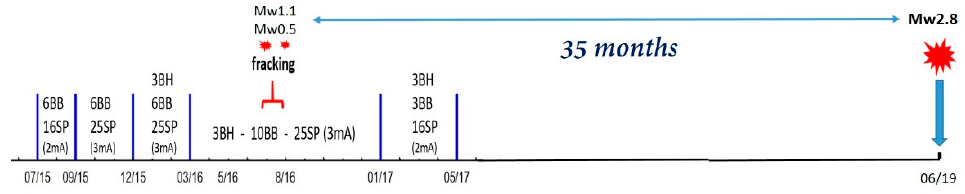
Figure 1. Schematic time scale of seismic monitoring around the Wysin site in the framework of the SHEER project, hydrofracturing works in horizontal boreholes, the occurrence of two seismic events recorded by the SHEER monitoring network, and the occurrence of the earthquake discussed in the present paper.